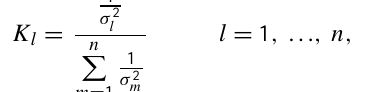
Figure 6. Images of the Jindo radar rain rate estimations for the four different precipitation cases of (a) case 1, (b) case 2, (c) case 3, and (d) case 4. The black boxes in the rain images indicate the synthetic radar gap areas whose size is 0.3 ◦ × 0.3 ◦